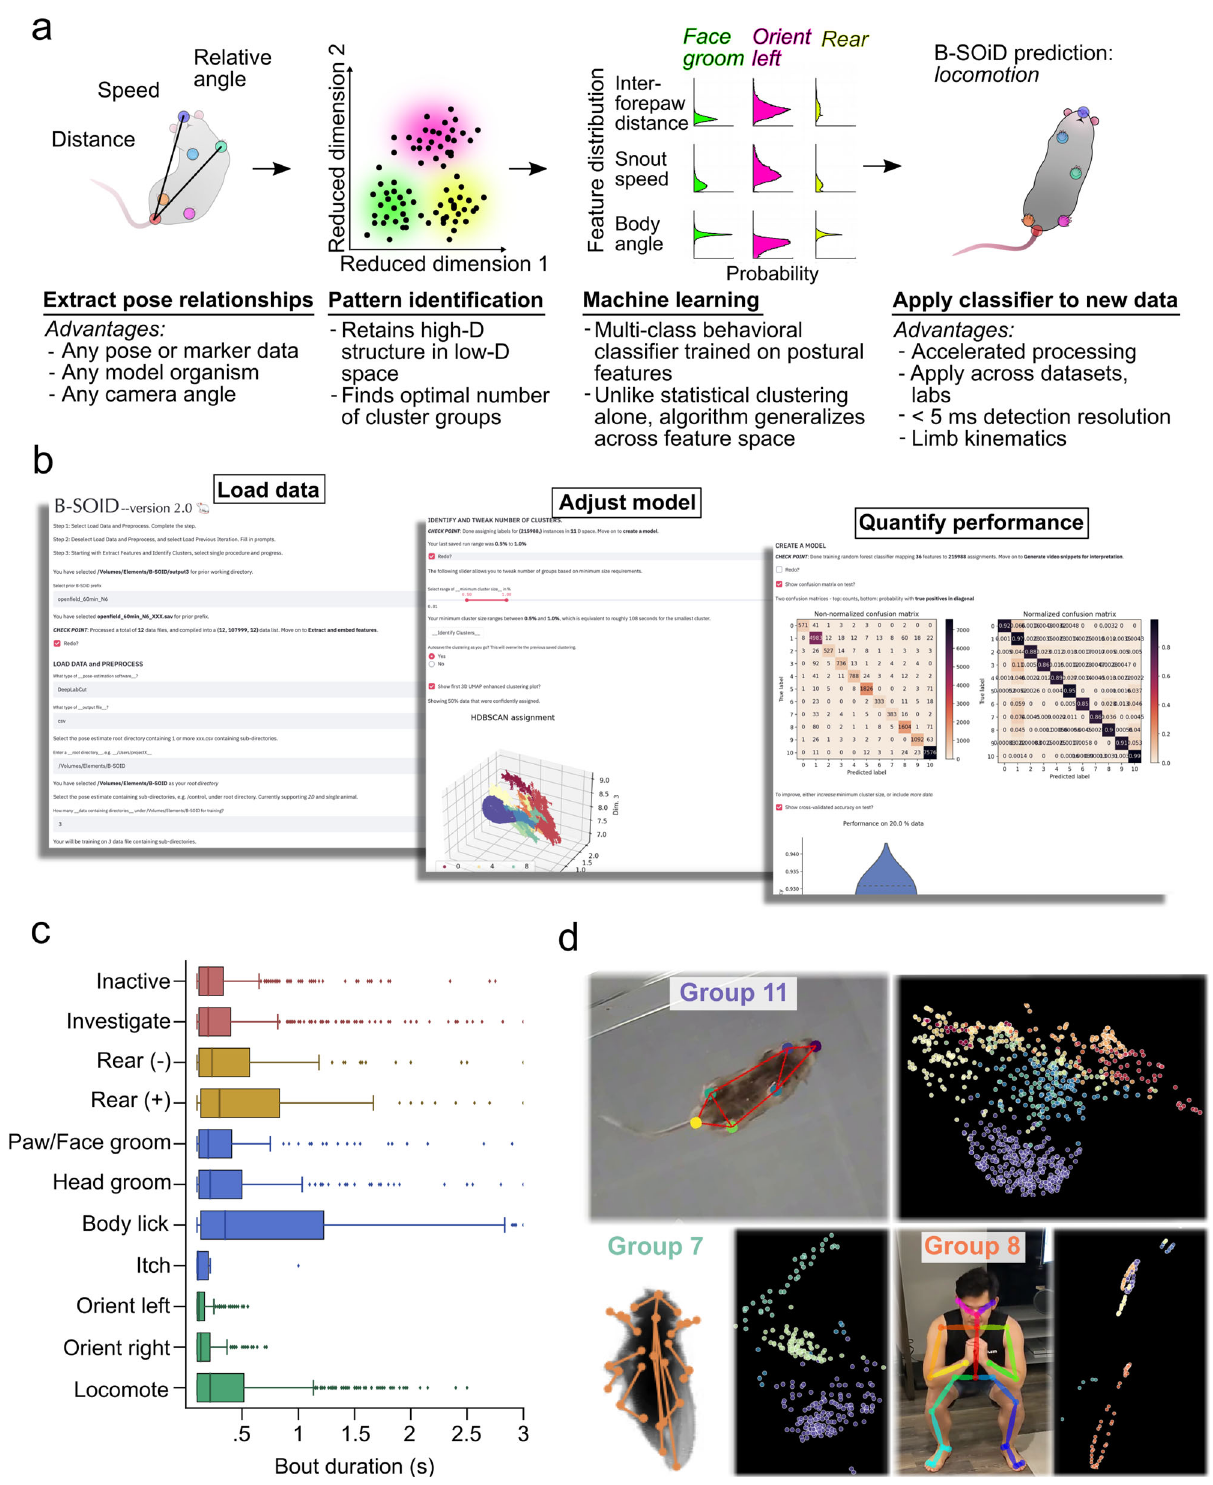
Fig. 1 Summary of B-SOiD process, GUI, and performance in mice and other animals. a After extracting the pose relationships that de fi ne behaviors, B-SOiD performs a non-linear transformation (UMAP) to retain high-dimensional postural time-series data in a low-dimensional space and subsequently identi fi es clusters (HDBSCAN). The clustered spatiotemporal features are fed as inputs to train a random forests machine classi fi er. This classi fi er can then be used to quickly predict behavioral categories in any related data set. Once trained, the model will segment any dataset into the same groupings. b Screen shots from B-SOiD app GUI, available freely for download. Examples of simple language progress from loading data, to improving model, and quantifying performance are shown. c Bout durations for each of the identi fi ed behaviors throughout an hour-long session, n = 1 animal. Data are presented as mean values ± SEM. d Snapshot of behavioral state space aligned to a freely moving mouse(DeepLabCut), fruit fl y(SLEAP), and the fi rst author - taken with a cell phone camera(OpenPose). Informed consent to publish the images was obtained. Color of group number refers to colored distribution within UMAP space. Source data are provided as a Source Data fi le for ( c